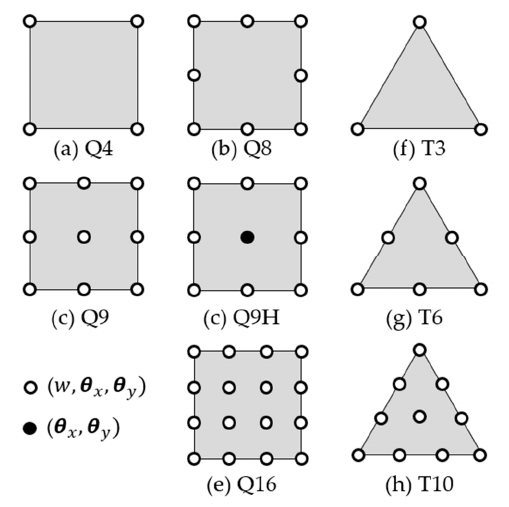
Figure 21. Finite elements based on the Reissner–Mindlin theory.